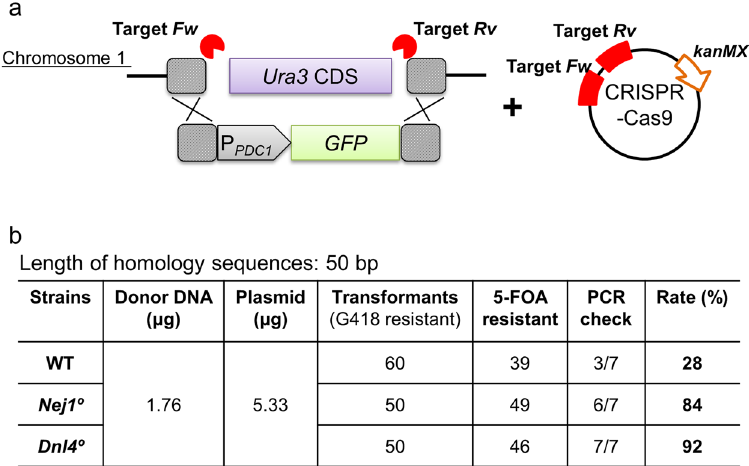
Figure 5. Markerless integration with short homologous arms. ( a ) Schematic of the transforming donor DNA fragment targeting the Ura3 locus and the CRISPR-Cas9 plasmid targeting two sites (indicated by lightning bolts) flanking the Ura3 CDS. Dashed boxes indicate homologous regions. ( b ) Homologous recombination rate ((5-FOA resistant * PCR check)/ transformants (G418 resistant) *